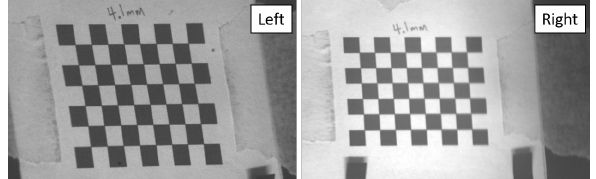
Figure 3. 2D calibration target used for finding the intrinsic and extrinsic camera parameters